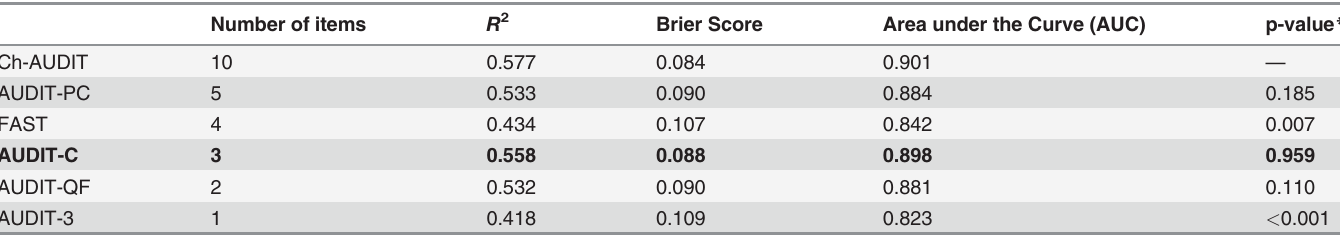
Table 2. Overall performance of abbreviated AUDIT compared to Ch –